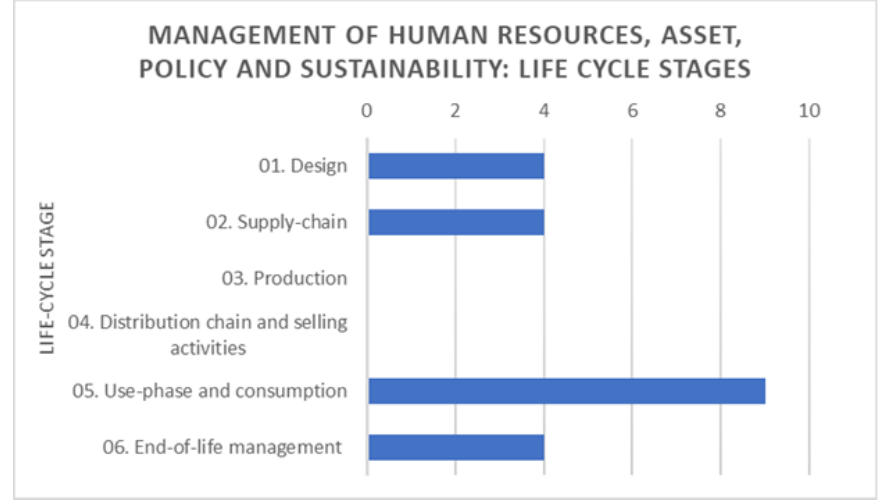
Figure 5. Lifecycle stages of the “Management of Human Resources, Assets, Policy and Sustainability” category (Source: Own elaboration)